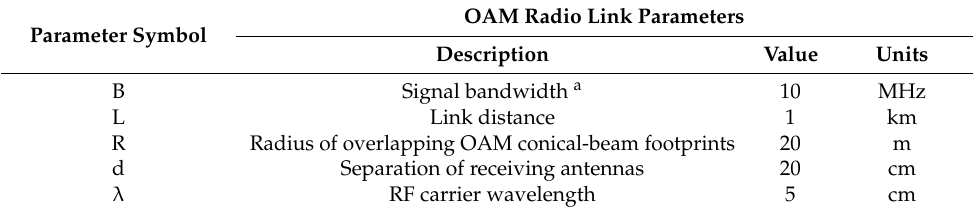
Table 1. Example Parameters of OAM Radio